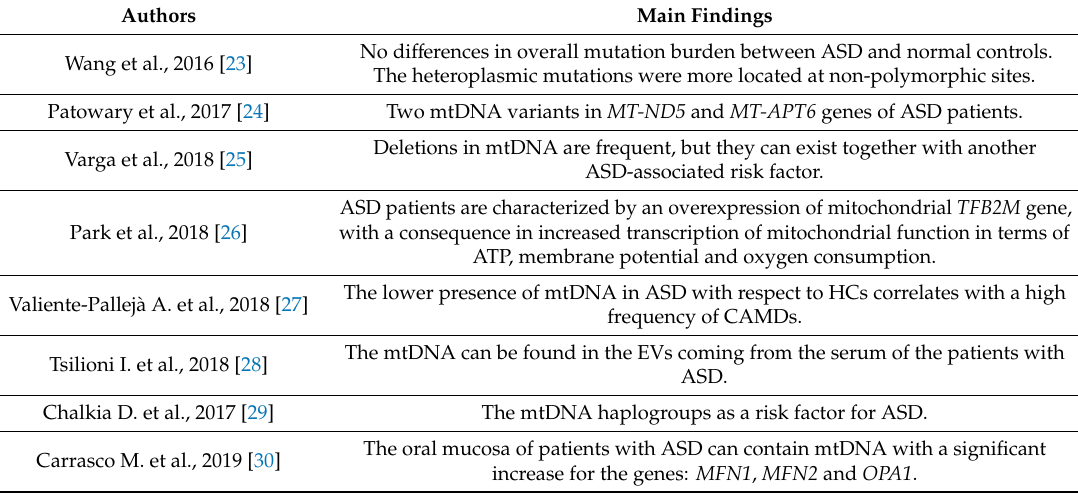
Table 2. Summary of the main findings of the Mitochondrial Dysfunction Hypothesis in